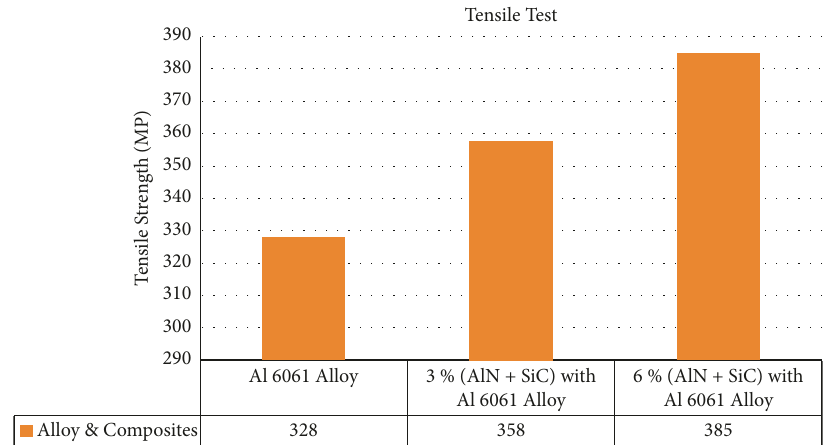
Figure 5: Tensile strength of the Al 6061 alloy and Al 6061 alloy-SiC-AlN hybrid composites.